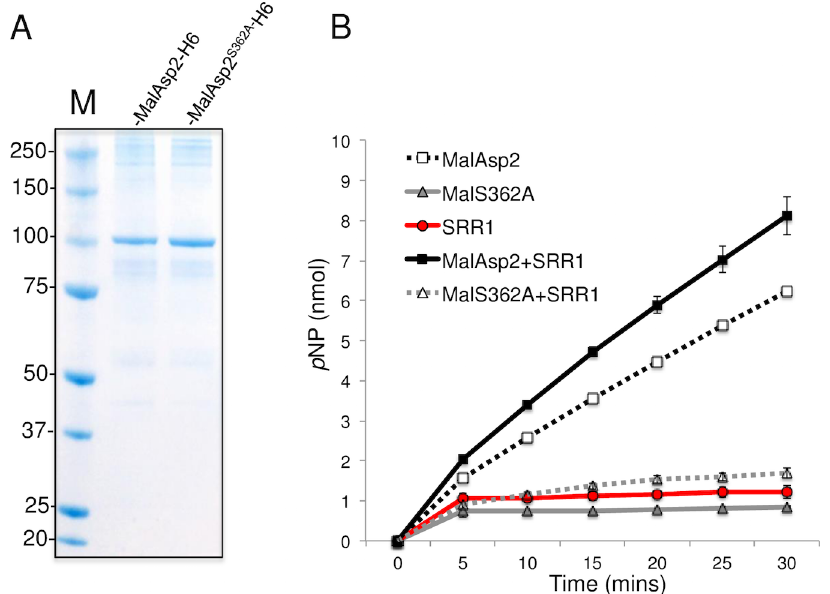
Fig 4. Determination of acetylesterase activity of Asp2. A) MalE-Asp2-H6 and the MalE-Asp2 S362A -H6 catalytic mutant followingexpressionin E . coli BL21 were purifiedon amylose resin, followedby Ni-NTA purification, and were analyzedby SDS-PAGE and Coomassiestainingof 5 μ g of the final purified recombinant protein. B) Time course of p -nitrophenol release from p NP-Ac in the presenceof glycosylated SRR1 (red circle), MalE-Asp2-H6 (black open square), MalE-Asp2 S362A -H6 (grey triangle),SRR1 with MalE-Asp2-H6 (black square) or SRR1 with MalE-Asp2 S362A -H6 (grey open triangle).Reactionswere incubatedat 25˚C in 50 mM sodium phosphate buffer (pH 7) and rates of p -nitrophenol release were measuredspectrophotometrically at 405 nm. Assays were performed in triplicate and data expressedas mean ± S.D nmol p NP released.Results shown are representative of at least two independent experiments.